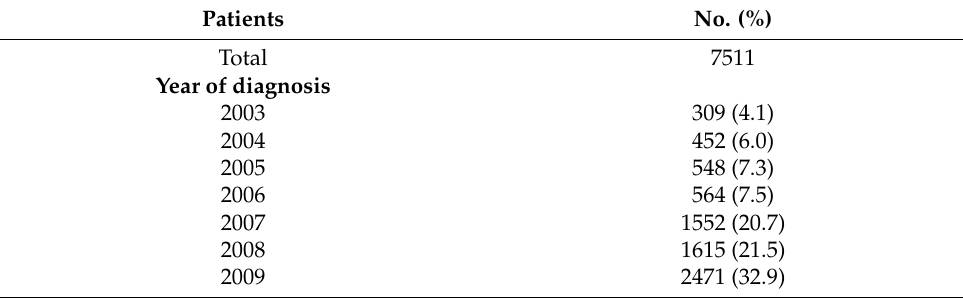
Table 1. Patient and treatment